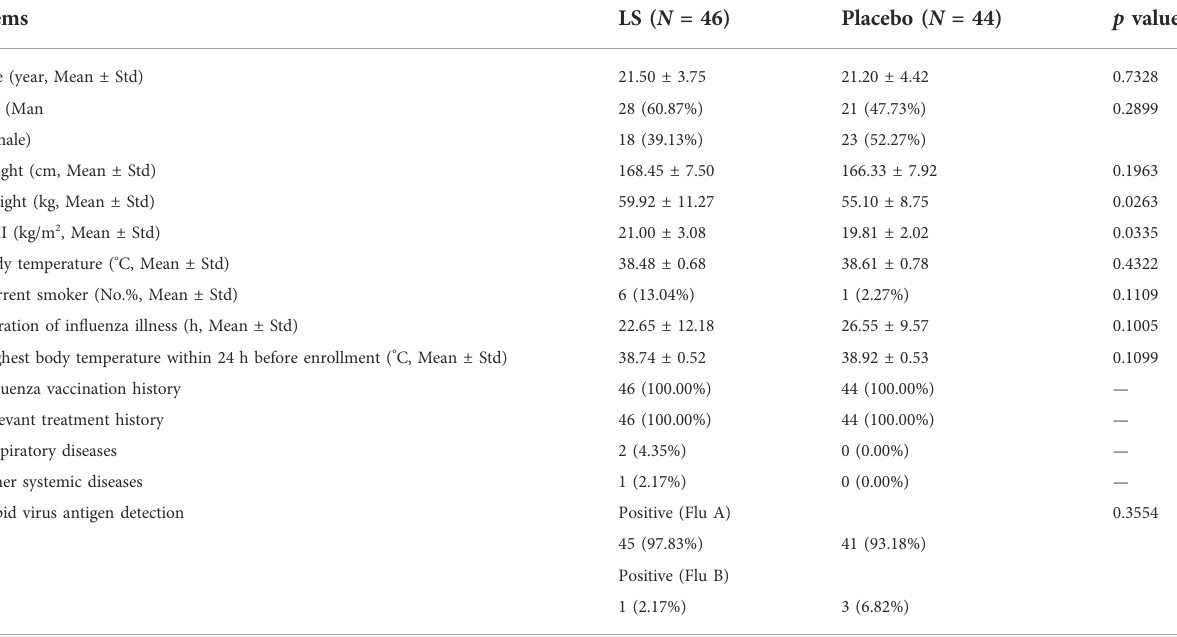
TABLE 2 General information on participants in the two groups.